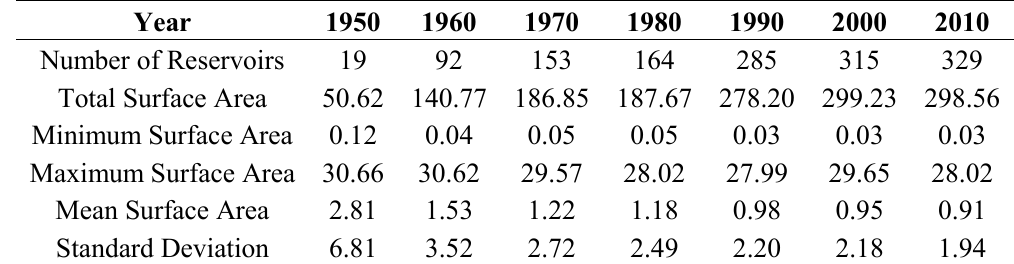
Table 2. Reservoir quantity and surface area statistics (h) in all watersheds, 1950–2010.